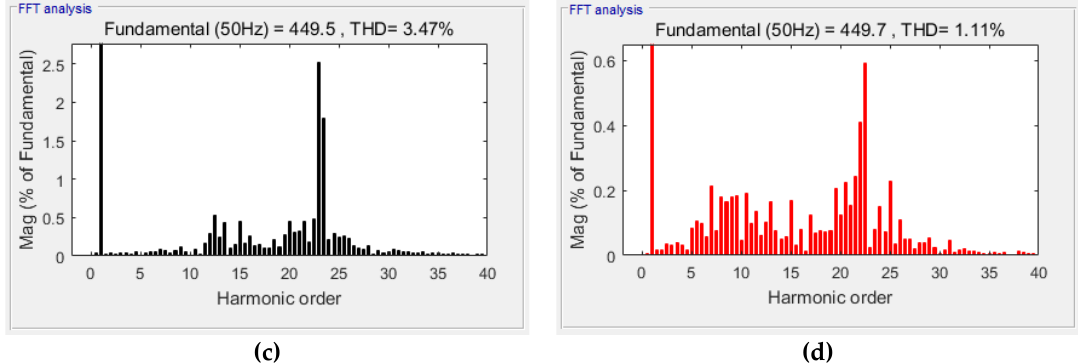
Figure 13. Comparison of voltage waveforms of DC bus and harmonic distortion rate of grid-connected point current under steady-state operation of two control strategies ( a ) Comparison of overall voltage fluctuations ( b ) Comparison of local voltage fluctuations ( c ) Harmonic analysis in traditional double closed-loop control mode ( d ) Harmonic analysis in dual closed-loop control mode based on LADRC.